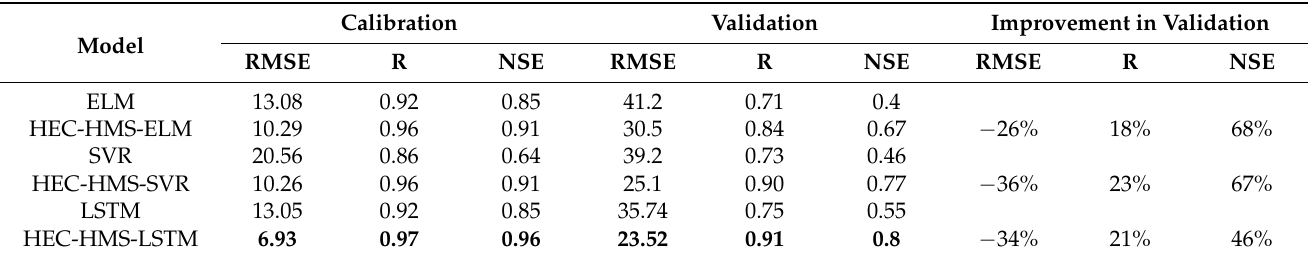
Table 4. Statistical measures of one-day streamflow forecasting during the calibration and validation